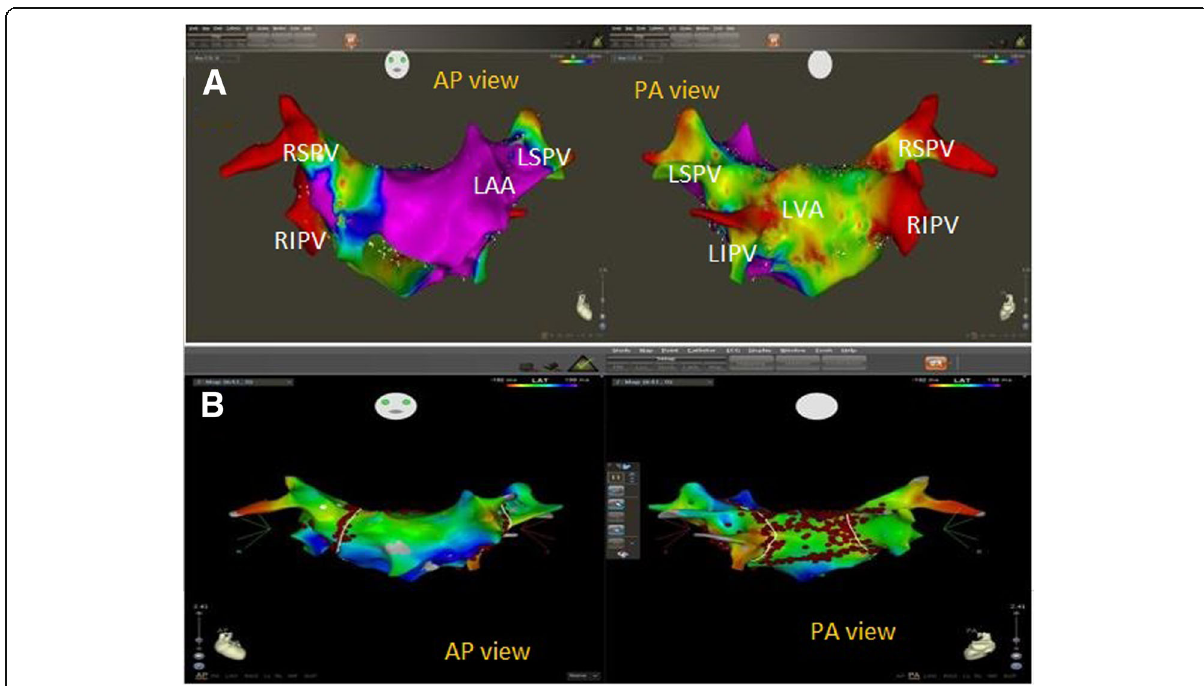
Fig. 2 Three-dimensional mapping of the left atrium (LA) and pulmonary veins (PVs) in a patient from the older population group with paroxysmal AF. a Abnormal bipolar voltage map of LA showed a large low-voltage area (LVA) in the posterior wall. b Combined circumferential pulmonary vein isolation and electrical isolation of this LVA (box isolation) were performed in the same patient. LSPV: left superior pulmonary vein, LIPV: left inferior pulmonary vein, RSPV: right superior pulmonary vein, RIPV: right inferior pulmonary vein, LAA: left atrial appendage, LVA: low-voltage area, AP view: anteroposterior view, PA view: posteroanterior view